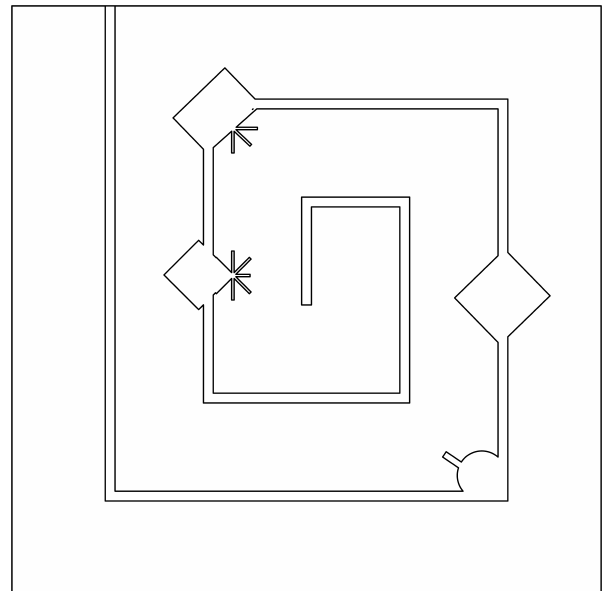
Figure 3. Labyrinth arena.